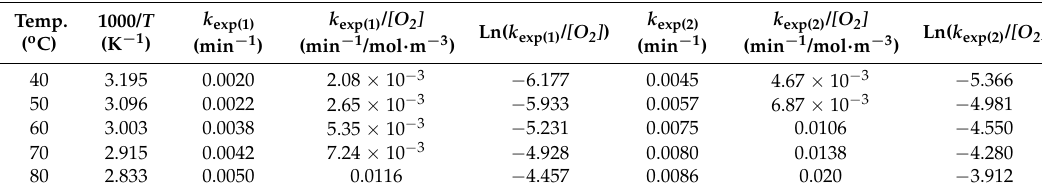
Figure 4. Effect of temperature on thiosulfate transformation: [S 2 O 32− ] initial , 1 g·L −1 ; [Cu 2+ ] initial , 0.053 g·L −1 ; pH constant , 5; O 2 pressure, 1 atm. Table 2. Effect of temperature on thiosulfate transformation.